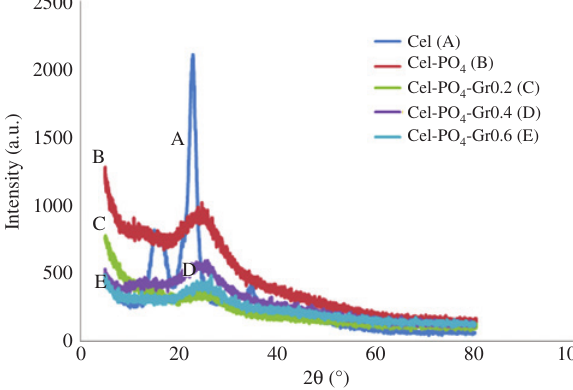
, (C) Cel-PO 4 -Gr 0.6. 4